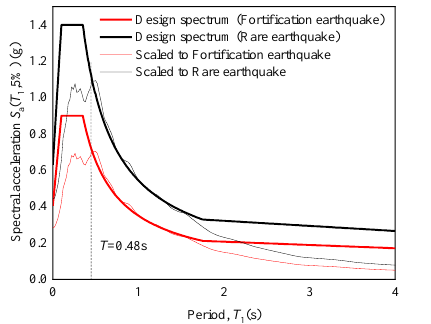
Figure 15. Design spectrum during fortification and rare earthquake events.